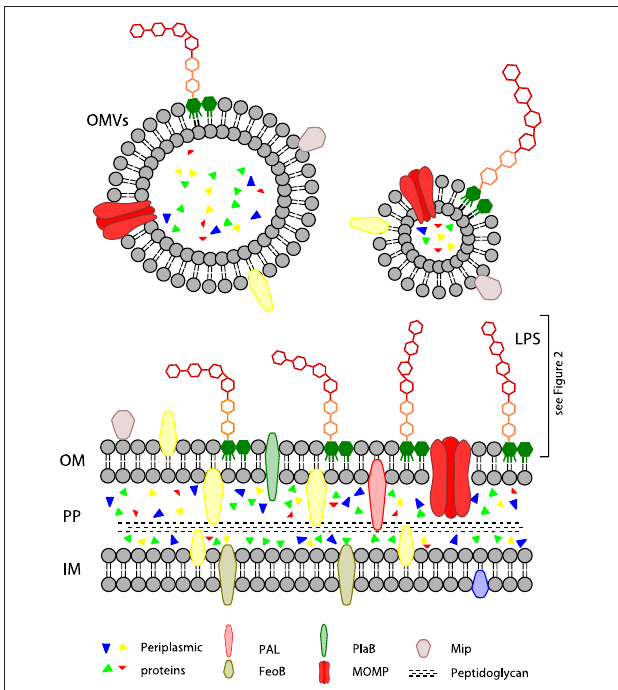
Figure 1 | Overview of the L. pneumophila cell envelope . CP, cytoplasm; IM, inner membrane; PP, periplasm; OM, outer membrane; OMVs, outer membrane vesicles; LPS, lipopolysaccharides; PAL, peptidoglycan-associated lipoprotein; FeoB, iron transporter; PlaB, phospholipase A/lysophospholipase A; MOMP, major outer membrane protein; Mip, macrophage infectivity potentiator.